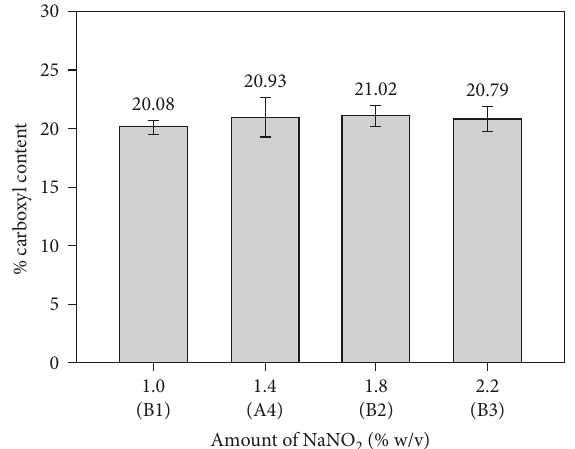
Figure 4: Effect of amount of NaNO 2 on the carboxyl content of the OC. The reactions were performed at 30 ° C for 24 hours by using HNO 3 /H 3 PO 4 1: 3 of acid mixture. (cid:31)